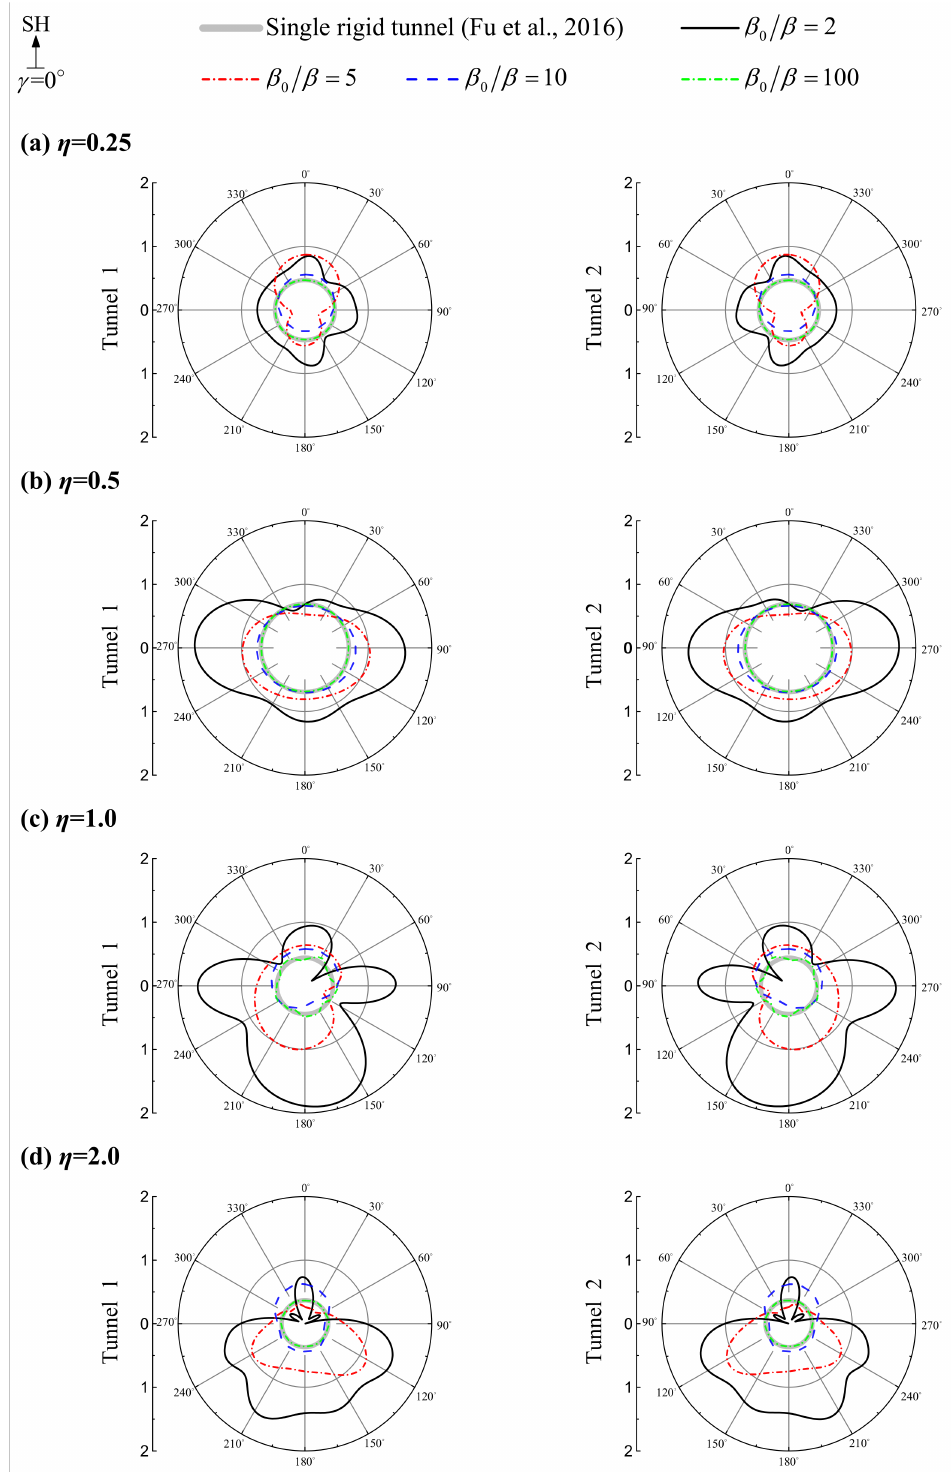
Figure 4. Typical spectral amplification of the tunnel displacement responses under different tunnel relative stiffness ( β 0 / β ) and dimensionless frequency ( η ) of the incident wave. Tunnel burial depth D / a = 2, tunnel distance s / a = 5, incident angle γ = 0 ◦ (vertical incident). Left column: tunnel 1; right column: tunnel 2. Parts ( a – d ) correspond to the dimensionless frequency η = 0.25, 0.5, 1.0, and 2.0,